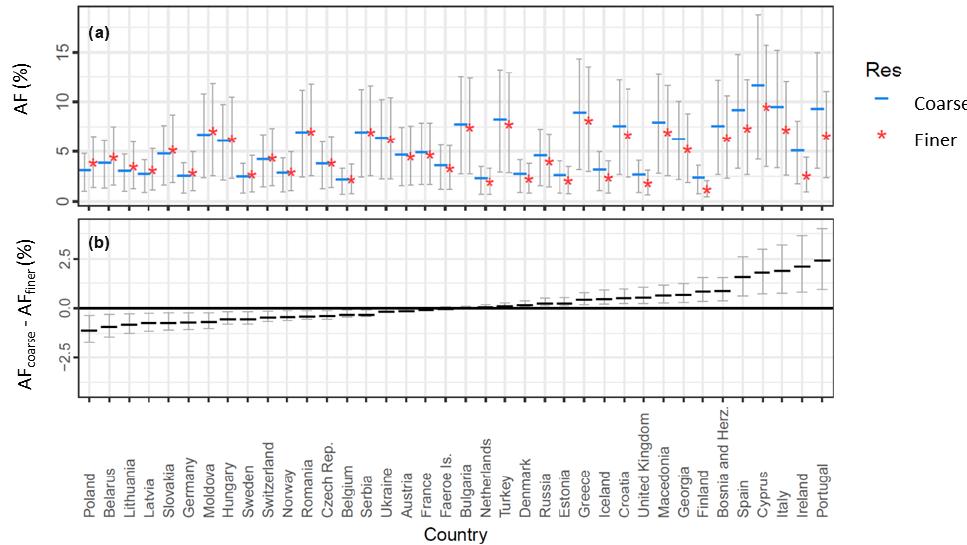
Figure 7. (a) AF associated with long-term exposure to daily maximum 8h running mean O 3 for each model resolution expressed as a percentage. (b) Differences in AF between the two resolutions expressed as a percentage for each European country (AF coarse − AF finer ). Grey lines show the 95% CI which represents uncertainties associated only with the concentration–response coefficient